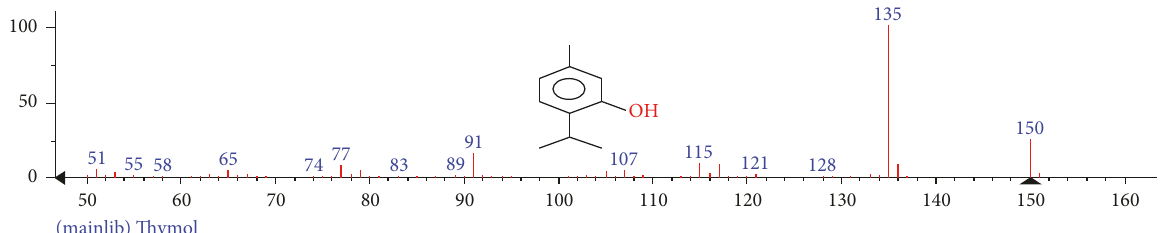
Figure 18: Mass spectrum of compound thymol of whole plant hexane fraction of Achillea wilhelmsii